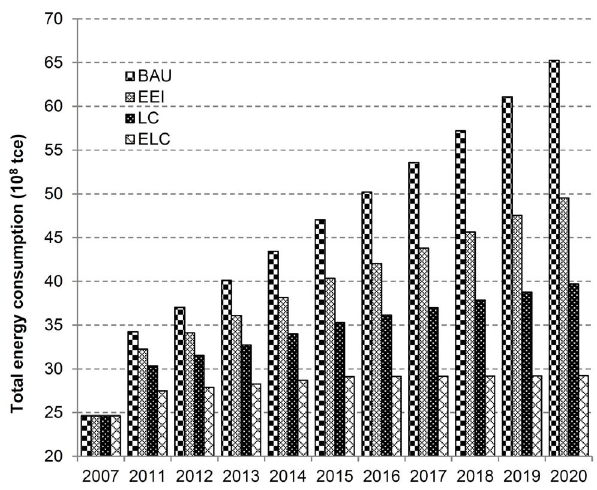
Figure 2. China’s total energy consumption under BAU, EEI, LC and ELC scenarios. (Scenarios are defined in Table 2).